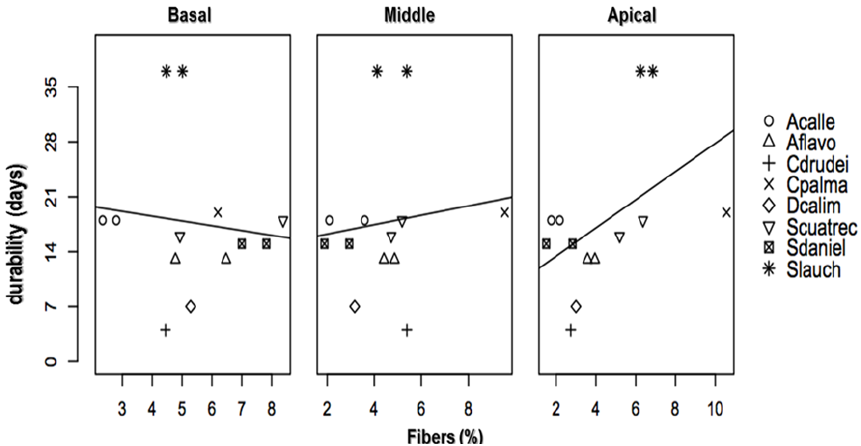
Figure 4 - Mean values of the percentage of fiber compared with durability in vase for eight species of Cyclanthaceae. See species names in Table I.